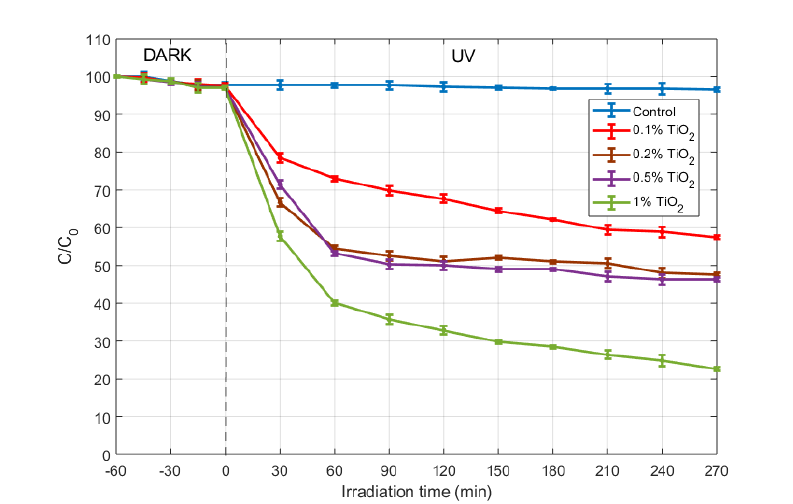
Figure 6. Photocatalytic MB dye degradation percentage with various time intervals for anatase sols inserted in mortar with different TiO 2